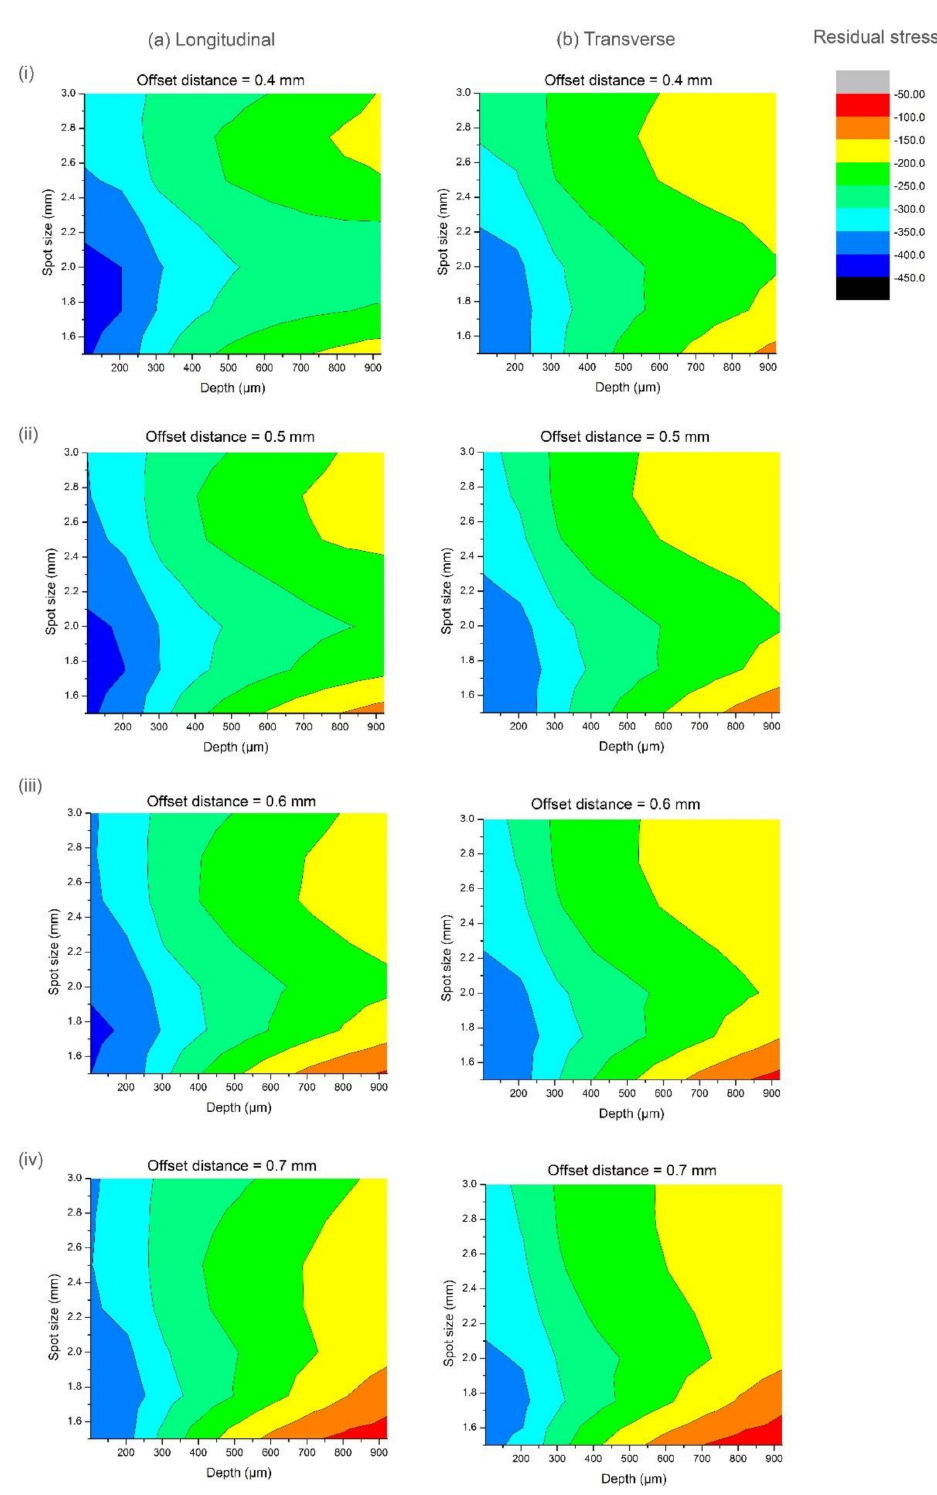
Figure 10. Parametric studies showing the variation of residual stresses as a function of spot size for different offset distance and layer parameters in multiple-shot laser peening data with overlap (dataset